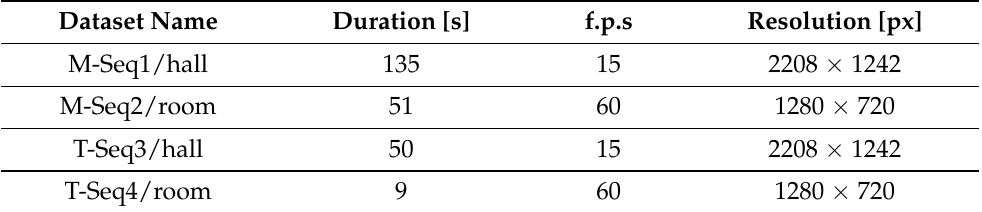
Table 2. Descriptions of video sequences for mapping and localization